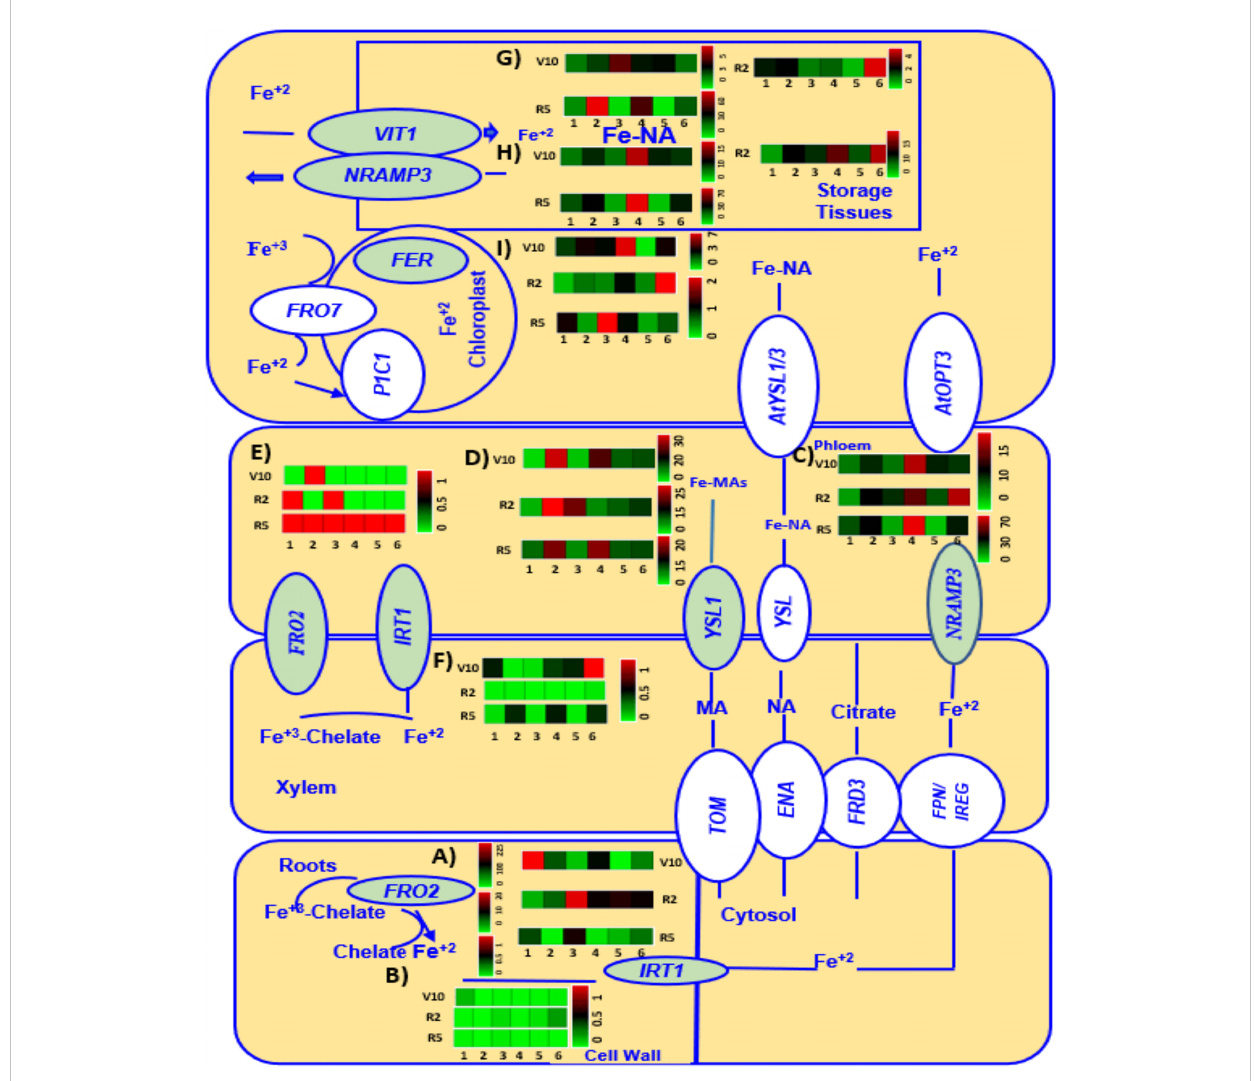
FIGURE 6 A heatmap analysis showing the gene expression patterns of Fe metabolism related genes FRO2 (A, E) , IRT1 (B, F) , NRAMP3 (C, H) , YSL1 (D) , V1T1 (G) , and FER3 (I) in roots and leaves of six different genotypes (1 = CDC Verano, 2 = Cermi 075, 3 = FLIP97-677C, 4 = Sarik 067, 5 = Kalka 064, and 6 = CDC 551-1). The data at V10, R2 and R5 growth stages taken only from Fe added (Fe + ) conditions. Green and red color represents down-regulation, and up-regulation in the color scale,